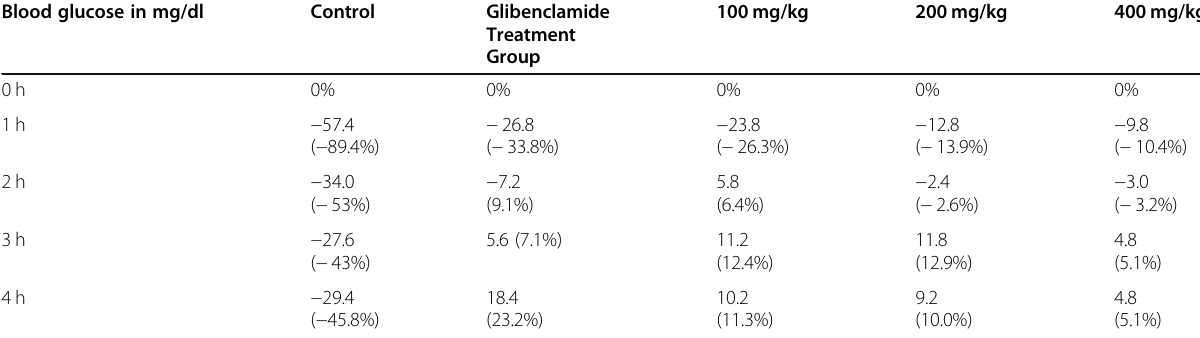
Table 6 Blood Glucose Difference & Percentage reduction in Glucose challenge test (OGTT) In rats treated with A. inermis Extract Blood glucose in